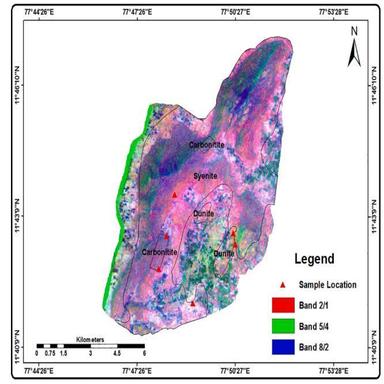
Band ratio image of Pakkanadu Carbonatite Complexes generate using ASTER band 2/1, 5/4, 8/2 in RGB and the carbonatite seen in blurred blue color, syenite in pink color and dunite in green color.